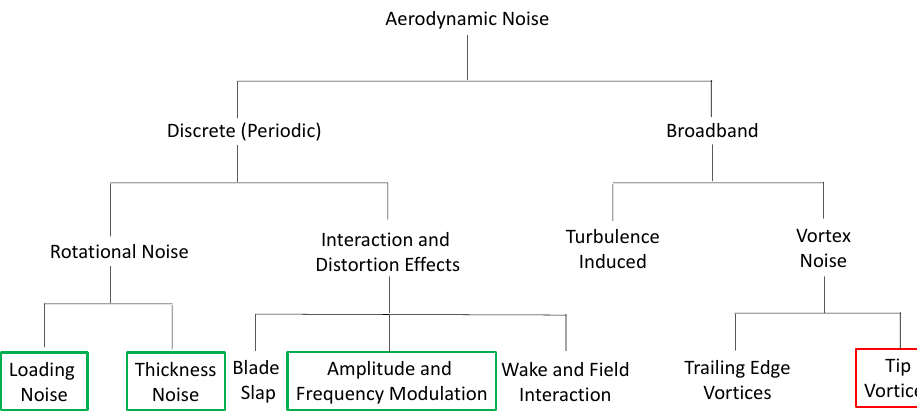
Figure 1. Sources of the aerodynamic noise from a rotating blade, reproduced from [10]. The sources in the colorful boxes are usually predominant, and the one in the red box is the focus in this paper. Note that the loading and thickness noise can also be related to part of the broadband noise if flow separation or turbulence near the blade exists. Moreover, tip vortices can generate tonal noise under certain conditions, e.g.,